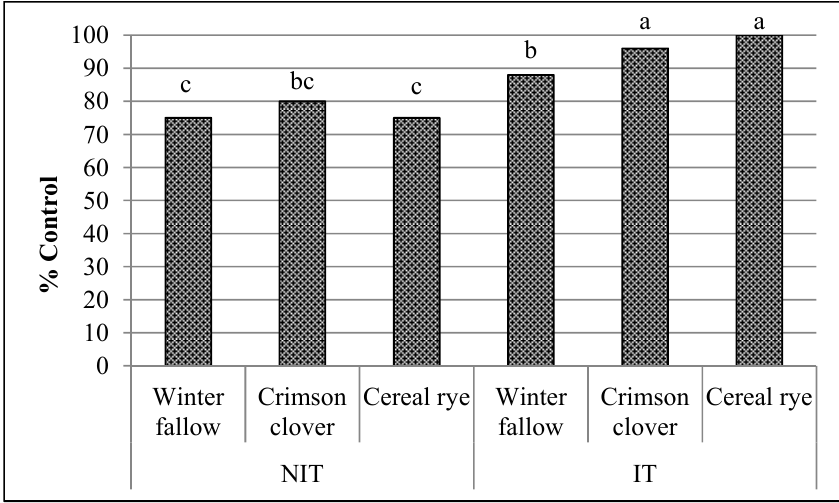
Figure 1. Soil-inversion by cover crop interaction on Palmer amaranth control in 2011. Different letters indicate significant differences at P =